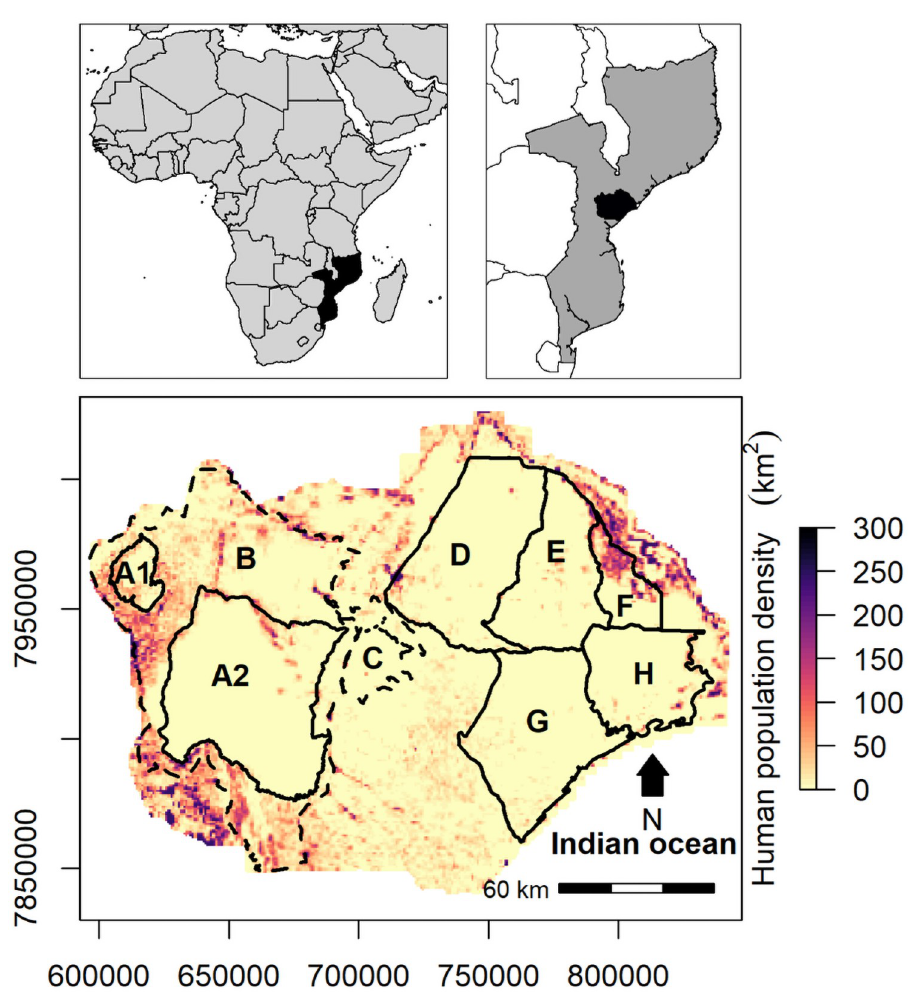
Fig 1. The location of the Gorongosa-Marromeu landscape (bottom panel) within the Sofala province of central Mozambique (black shading in top right panel) on the east coast of Africa (black shading in top left panel). In the bottom panel, different protected areas are shown with solid lines indicating official protected area status and dashed lines for buffer-zones and adjacent forestry areas overlaid on human population density (number of people per 1 km 2 ). The human population density data were collected by Gorongosa National Park’s Department of Scientific Services. Letters refer to (A1) Mountain section of Gorongosa National Park, (A2) core area of Gorongosa National Park, (B) buffer area of Gorongosa National Park, (C) forestry areas, (D) Coutada 12, (E) Coutada 11, (F) Coutada 14, (H) Marromeu National reserve and (G) Coutada 10.